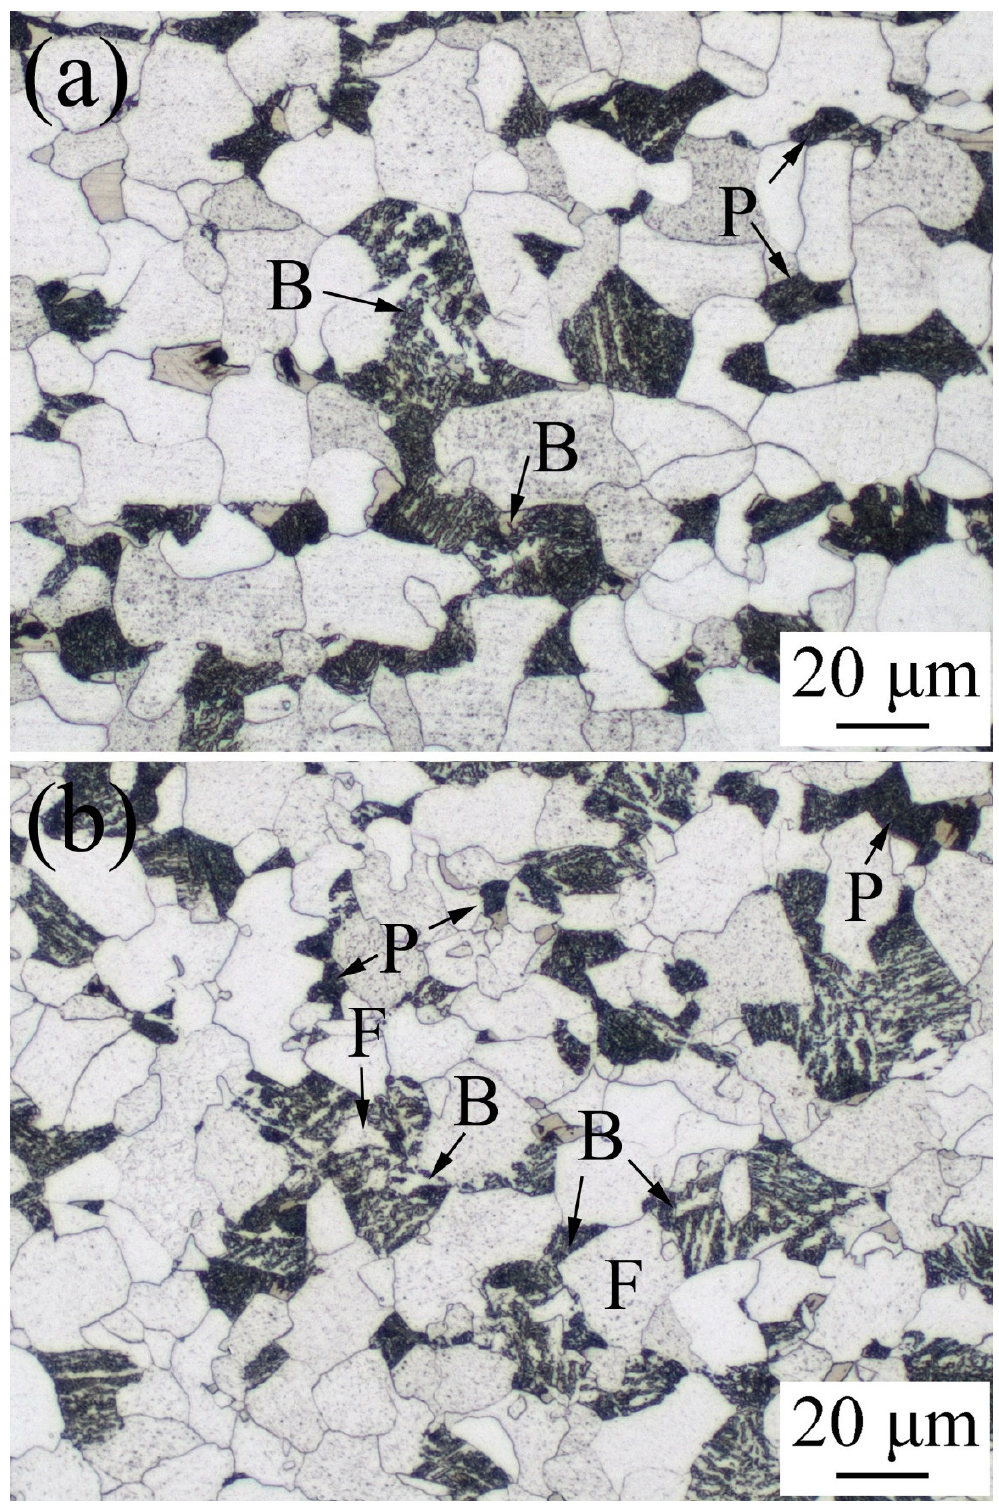
Figure 2. Microstructures of hot-rolled steels: ( a ) N1-HR, ( b ) N2-HR.